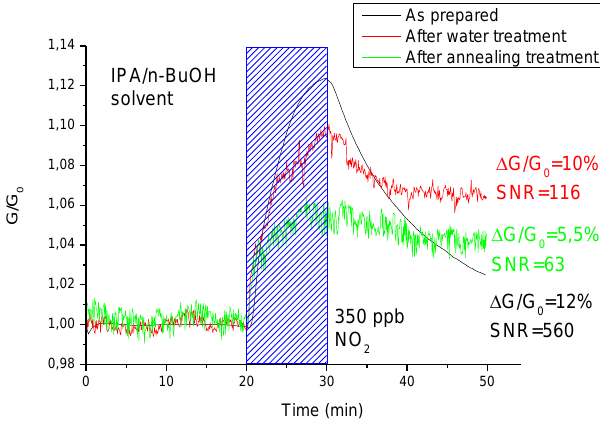
Figure 1. Normalized electrical conductance behaviors for chemi-resistors towards 350 ppb of NO 2 in a wet N 2 environment as soon as prepared (black line), after one month (red line), after the restora- tion by the dipping method (green line), and after the restoration by the annealing method (blue line). The standard protocol adopted in these tests consists of the baseline of 20min in wet N 2 , the window exposure of 10min to NO 2 (blue dashed color area in the figures), and the recovery phase of 10min. The graphene was exfoliated us- ing NMP as a solvent.